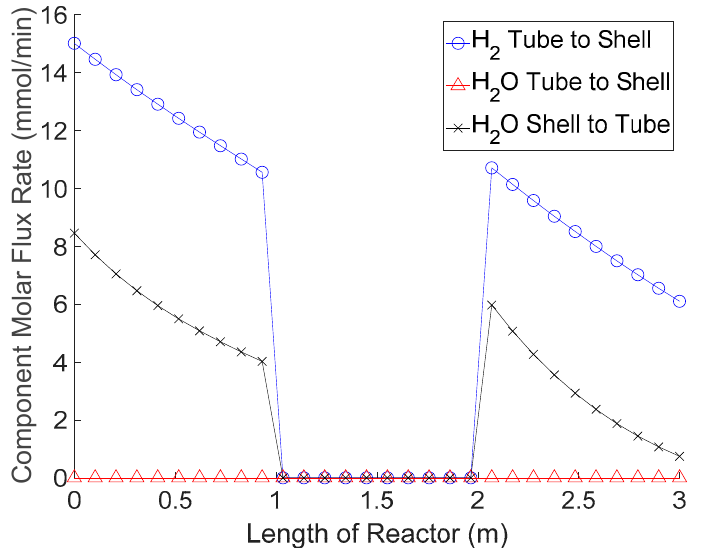
Figure 14. Flux profiles for the modified membrane reactor design with the membrane tube being